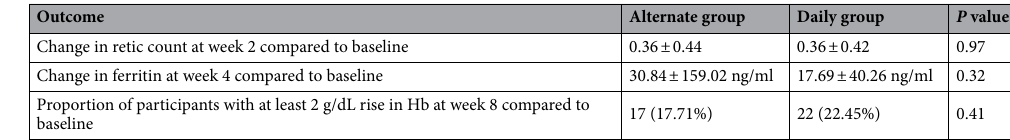
Table 2. Major secondary outcomes in the two arms at weeks 2, 4 and 8 of randomization.